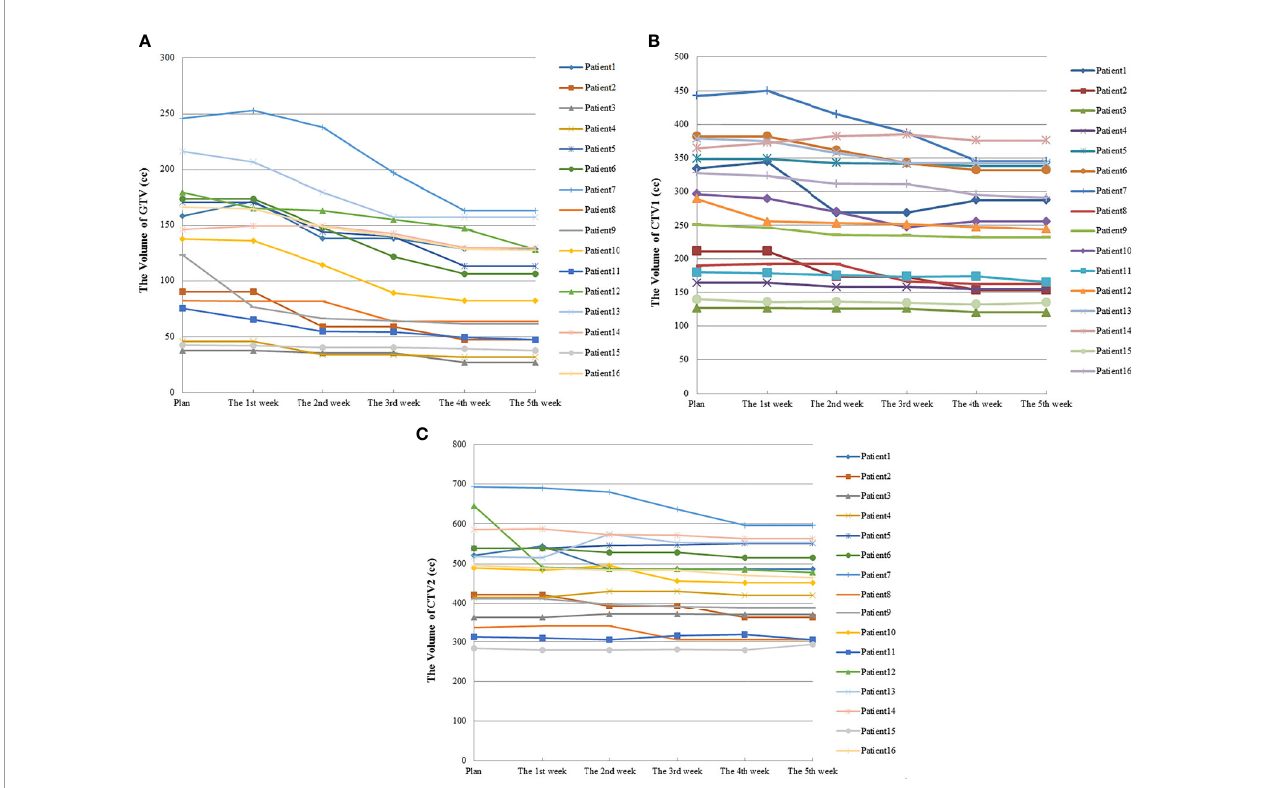
FIGURE 2 | Volume changes in TV during radiotherapy for 16 esophageal cancer patients. (A) was the volume changes of GTV; (B) was the volume changes of CTV1; (C) was the volume changes of CTV2.